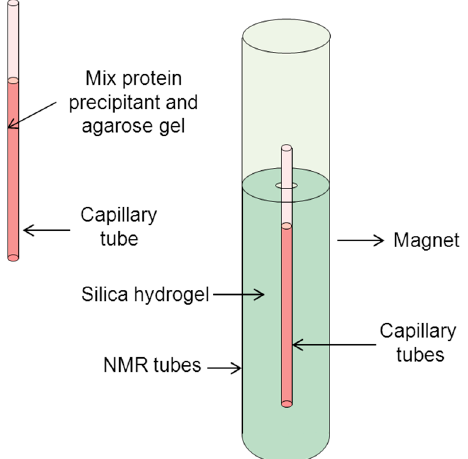
Figure 9. Schematic drawing of the experimental device for protein crystallization in gels. The gels were placed within capillary tubes located inside NMR tubes in magnetic fields [45].